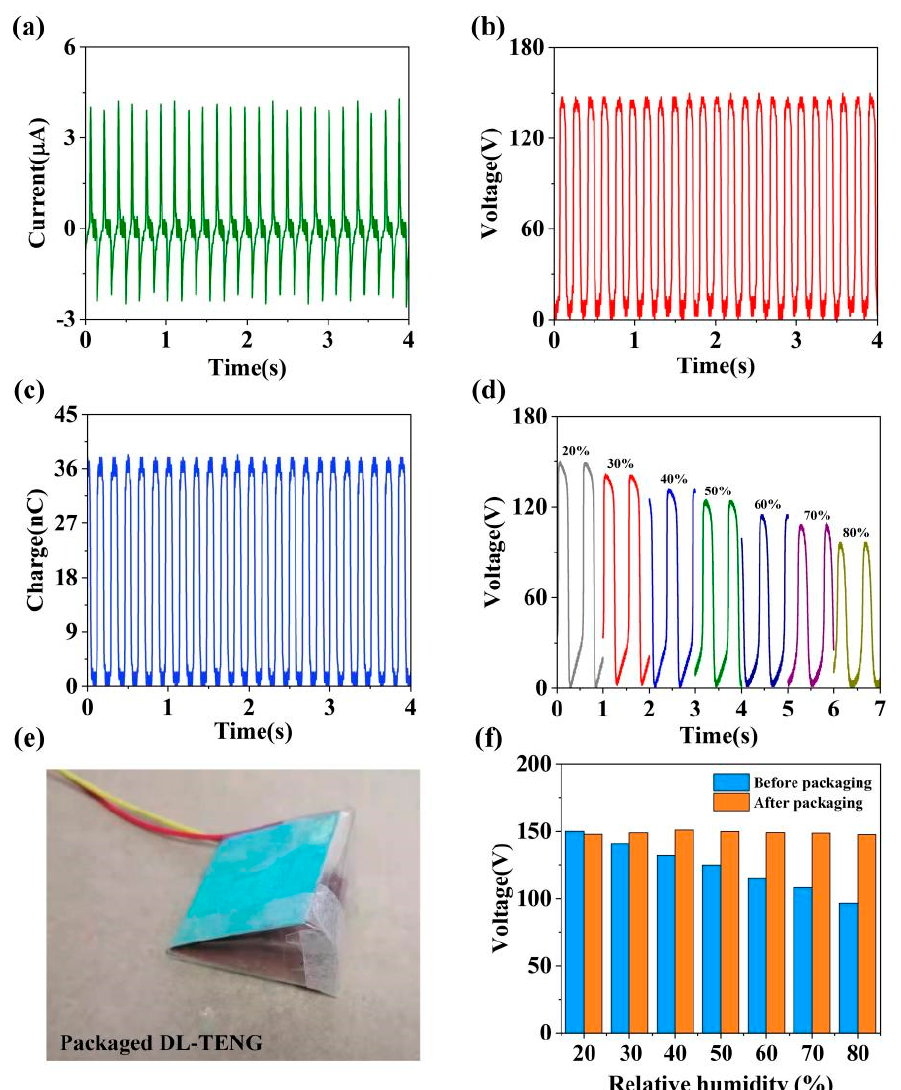
Figure 3. The ( a ) I sc , ( b ) V oc , and ( c ) transferred charge of DL-TENG. ( d ) The electrical output of DL-TENG under different relative humidities. ( e ) The schematic diagram of packaging structure DL-TENG. ( f ) The electrical output of DL-TENG before and after packaging under different relative humidities.